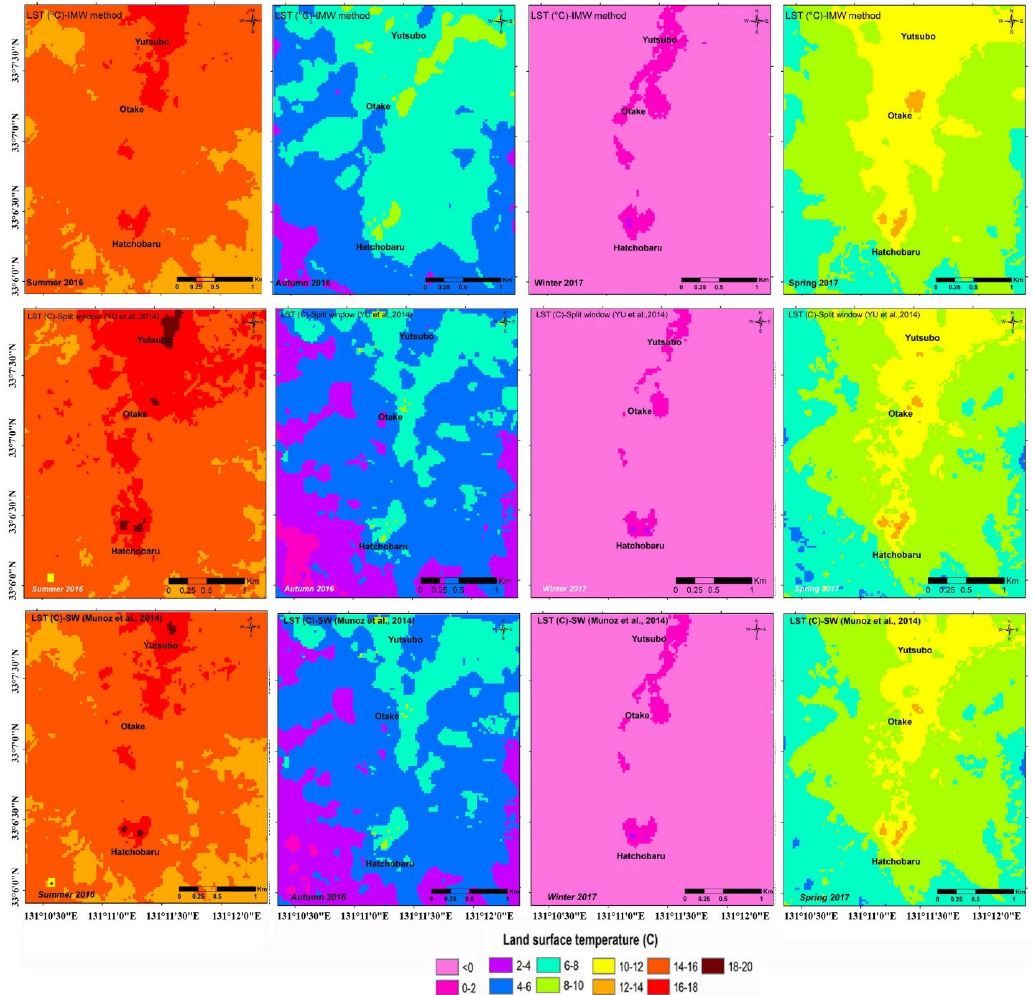
Figure 16. Seasonal land surface temperatures (LSTs) for the study area derived from nighttime Landsat 8 thermal infrared data. The LSTs for each season processed using the improved mono-window (IMW) algorithm are shown in the top row; LSTs for each season processed using the split-window (SW) algorithm of Yu et al. [19] are shown in the middle row; while the LSTs for each season processed using the SW algorithm of Jiménez-Muñoz et al. [20] are shown in the bottom row. The seasons are arranged in the order of summer, autumn, winter, and spring, in all of the rows.